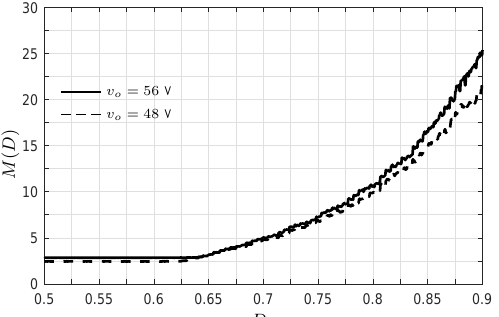
Figure 16. Experimental voltage conversion ratio using v o = 56 V (solid line) and v o = 48 V (dashed